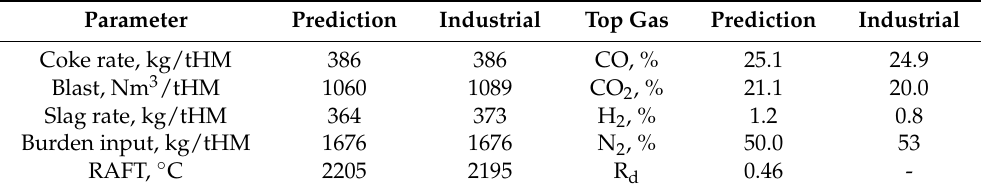
Table 2. Quantitative validation of the